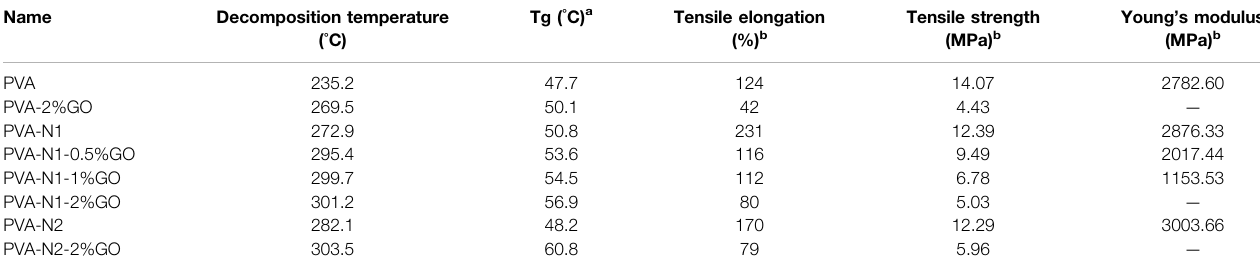
TABLE 1 | Properties of PVA, PVA-N, and their nanocomposites with